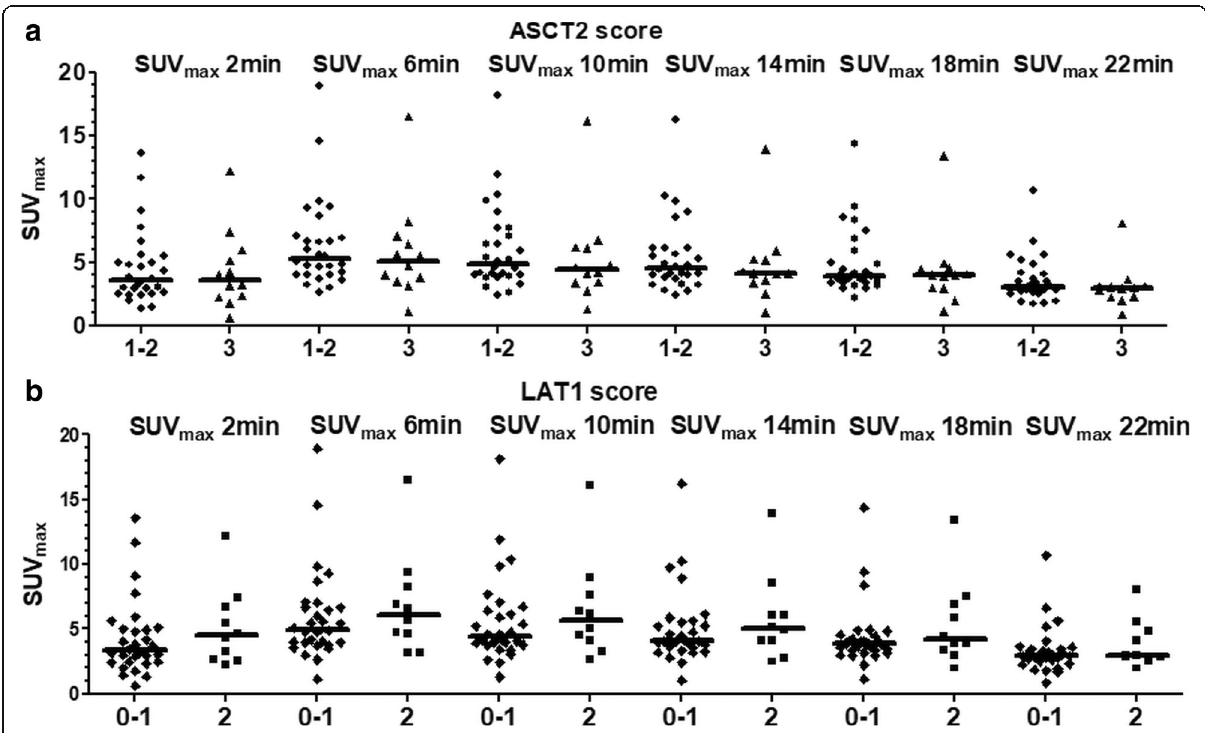
Fig. 2 Relationship between uptake of 18 F-fluciclovine and amino acid transporter expression in localized prostate cancer. Time course of uptake, expressed as SUV max of six consecutive 4-min frames and indicated by their middle time point is shown in comparison to ASCT2 ( a ) and LAT1 ( b ) represented in two staining intensity subgroups. For ASCT2, 1 – 2 denotes low-to-moderate and 3 high expression in a . For LAT1, 0 – 1 denotes negative-to-low and 2 moderate expression in b , respectively